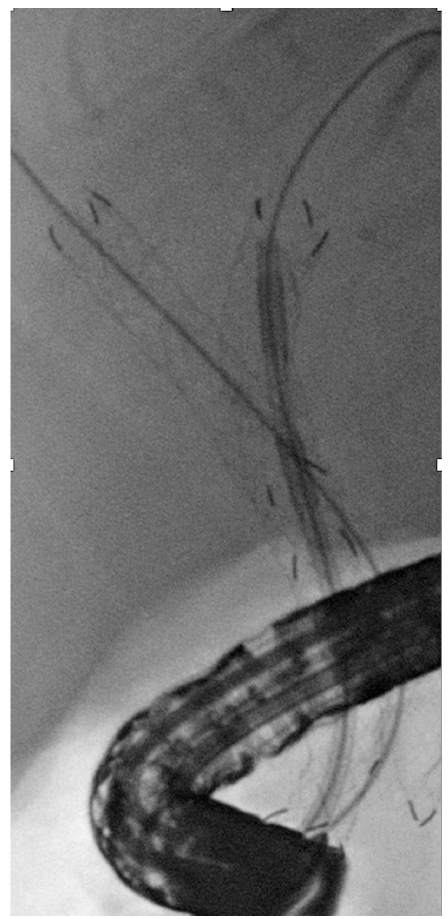
Figure 8. Radiofrequency ablation of hilar cholangiocarcinoma after self-expandable metal stents